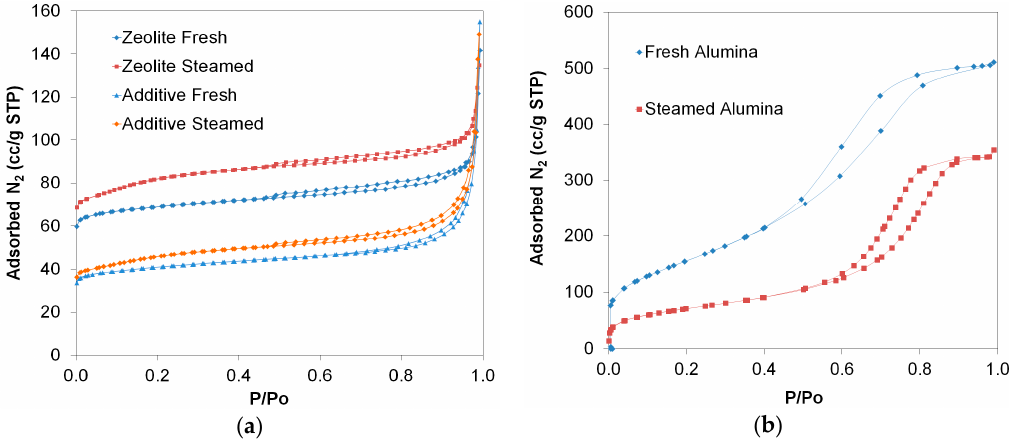
Figure 2. N 2 adsorption-desorption isotherms for: ( a ) P/H-ZSM-5 zeolites (fresh and steamed) and P/ZSM-5 additives (fresh and steamed); ( b ) silica-alumina (fresh and steamed); steaming conditions 770 °C, 7 h, He/steam flow (50% steam).